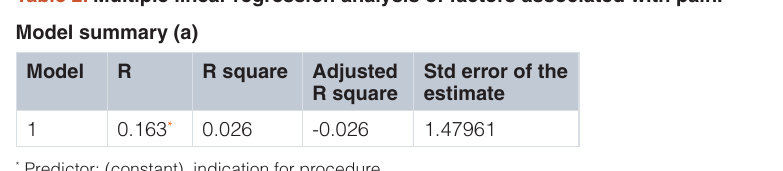
Table 2. Multiple linear regression analysis of factors associated with